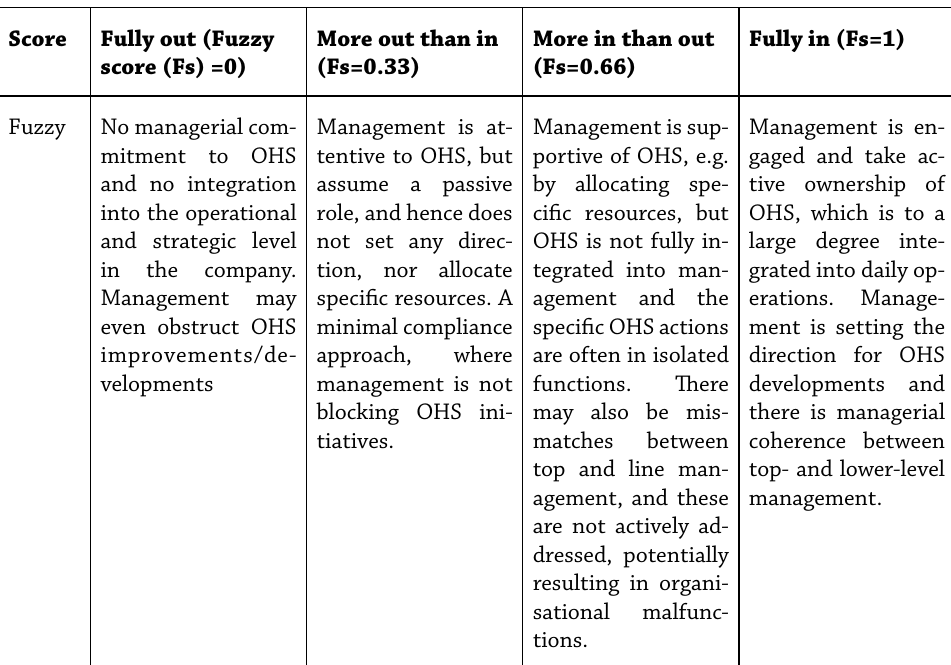
Table 4: Calibration of managerial